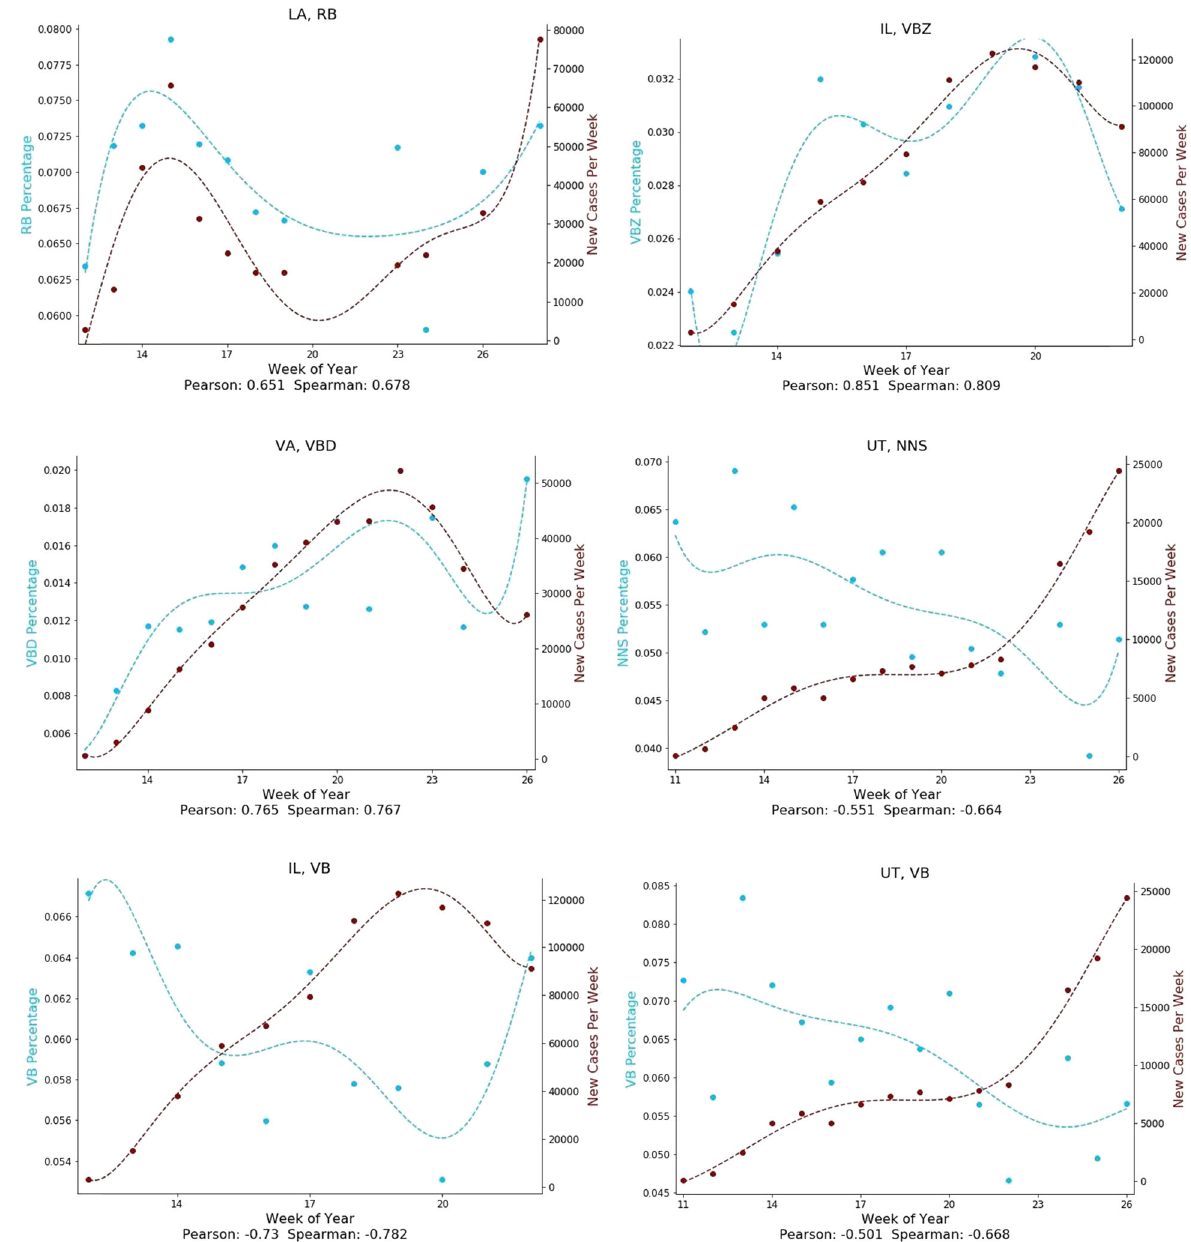
Fig. 6 Temporal associations of parts of speech with COVID-19 case rates. Both positive and negative associations are shown. States are represented by standard two-letter abbreviations. (VBD: Verb, past tense; VBZ: Verb, present tense; RB: Adverb; NNS: Noun, common,